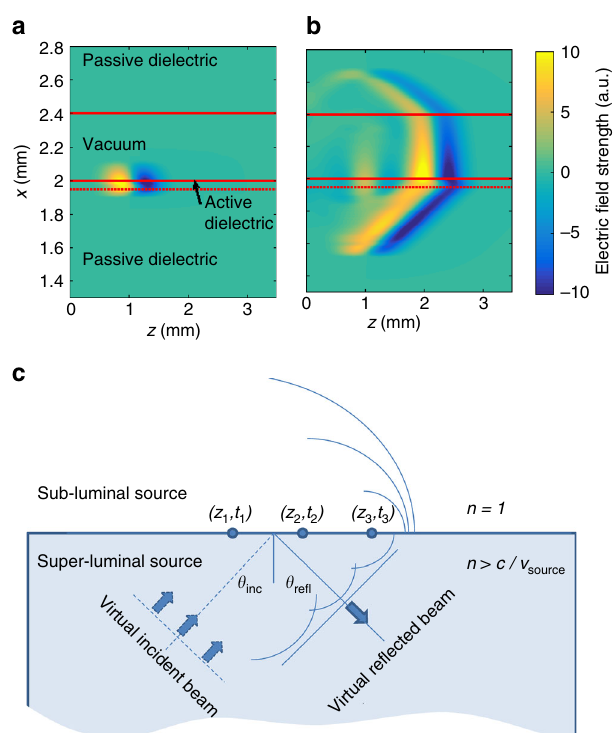
Fig. 2 The fi eld evolution for a nonlinear source within a dielectric. a , b Finite difference time domain calculations of the electric fi eld for a travelling source within a dielectric layer on a dielectric substrate. The terahertz source is only present within a 50 μ m active layer. The source velocity is greater than the speed of light within the dielectric, but less than the speed of light in vacuum. Time snap-shots are shown for a 0.5 ps and b 4.5 ps after the start of the nonlinear interaction. c The travelling source can be viewed as a surface excitation driven by a virtual incident plane wave. For a sub-luminal (in vacuum) effective surface velocity the angle of incidence for the virtual wave will exceed the critical angle for total internal re fl ection. For thicker source regions the virtual source has a real component propagating within the dielectric and spatio-temporal